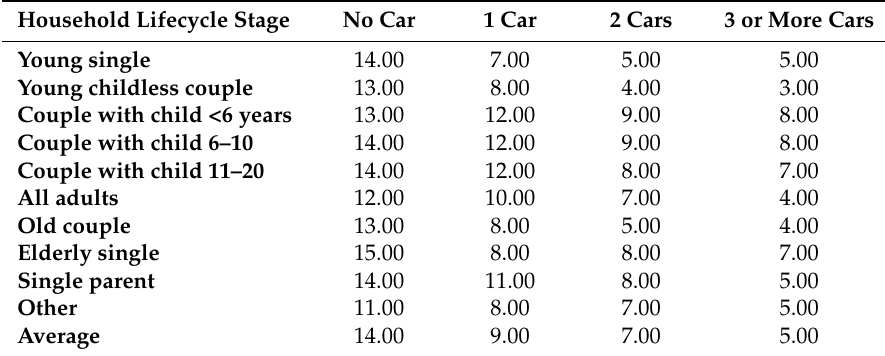
Reduction in the risk of mortality shown to the population by car ownership and lifecycle